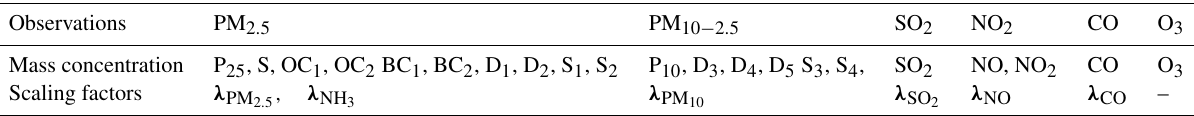
Table 2. State vectors in the data assimilation system. Observations PM 2 . 5 PM 10 − 2 . 5 SO 2 NO 2 Mass concentration O 3 Scaling